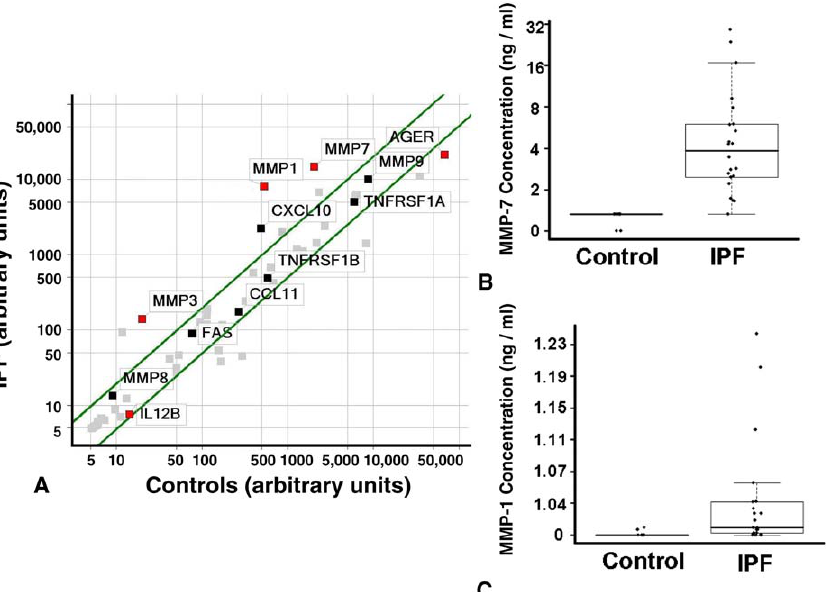
Figure 2. MMP7 and MMP1 Gene and Protein Levels Are Significantly Increased in the Lungs of Patients with IPF (A) Average gene expression levels (log scale) measured using gene expression microarrays of genes that encode the 49 protein markers in IPF lungs ( y - axis) compared to control lungs ( x -axis). Colored squares (black or red) are genes that encode proteins that changed significantly in plasma. Red squares are genes that changed significantly (SAM Q value , 5%) in gene expression data and that encode proteins measured in peripheral blood. Green oblique lines denote 2-fold change. (B and C) MMP7 (B) and MMP1 (C) concentrations (ng/ml) are significantly ( p , 0.00001 and p ¼ 0.018, respectively) higher in BAL fluid of patients with IPF ( n ¼ 22) compared to control individuals ( n ¼